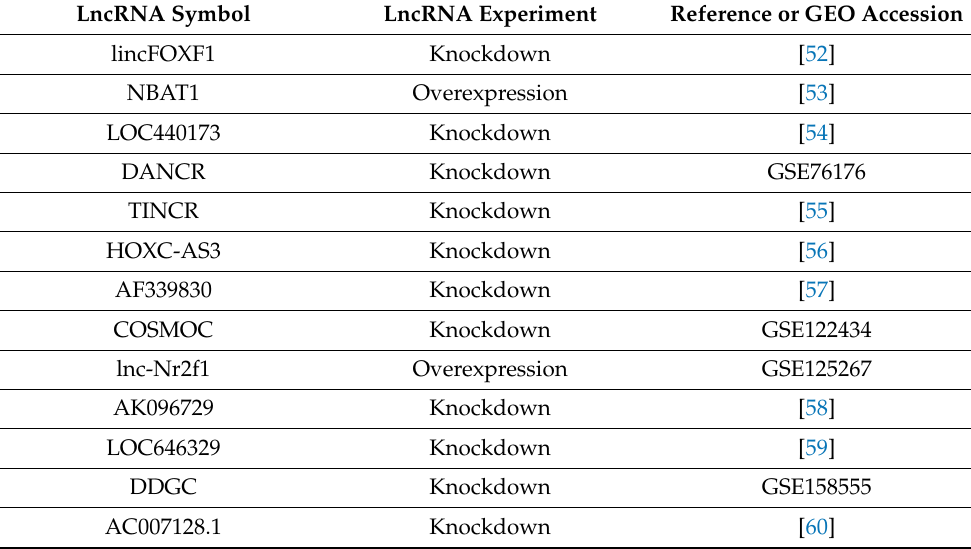
Table 4. lncRNA2Target v.3.0 results for differentially expressed